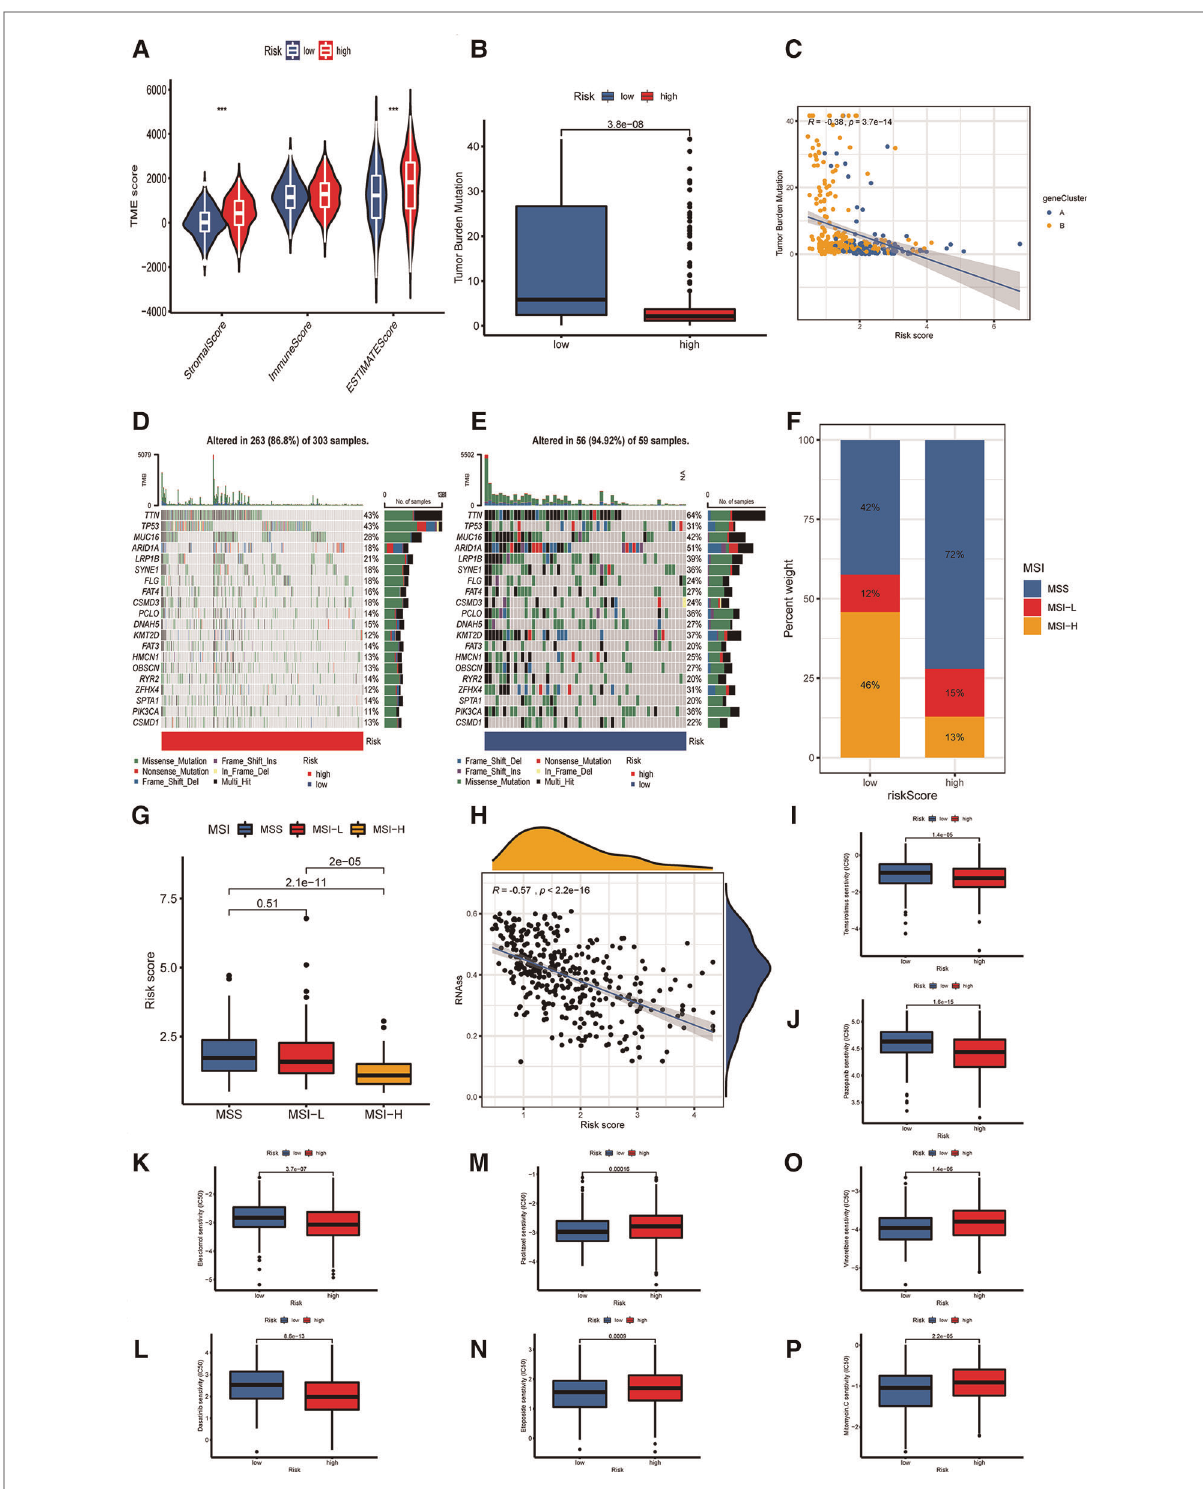
FIGURE 7 The relationship between OE_score and immunotherapy. ( A ) The correlation between the two OE_score-related subtypes and the TME score. ( B,C ) The correlation between OE_score and TMB. ( D,E ) OE_score high-risk and low-risk groups about the waterfall plot of TMB. ( F,G ) The correlation between OE_score and MSI. ( H ) the correlation between OE_score and CSC. ( I – P ) Sensitivity of patients with high and low risk of OE_score to various chemotherapautic drugs. TME, tumor microenvironment; TMB, tumor mutation burden; MSI, microsatelllite instability; CSC, cancer stem